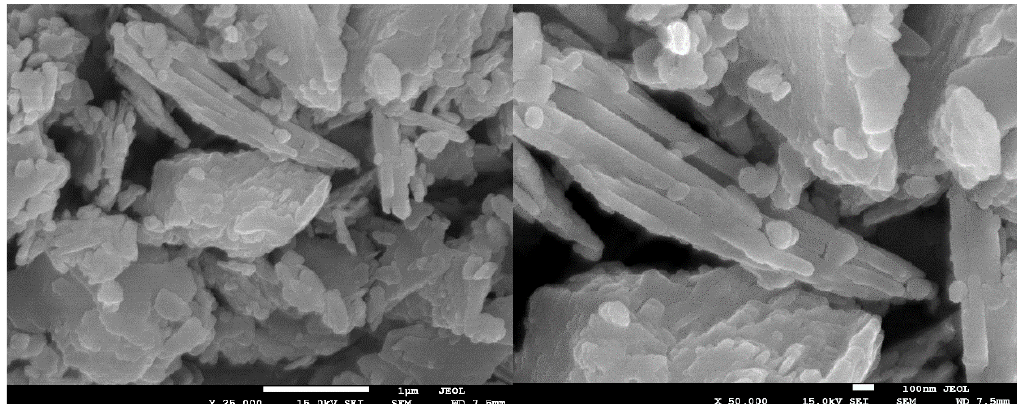
Figure 5. SEM images of non-modified